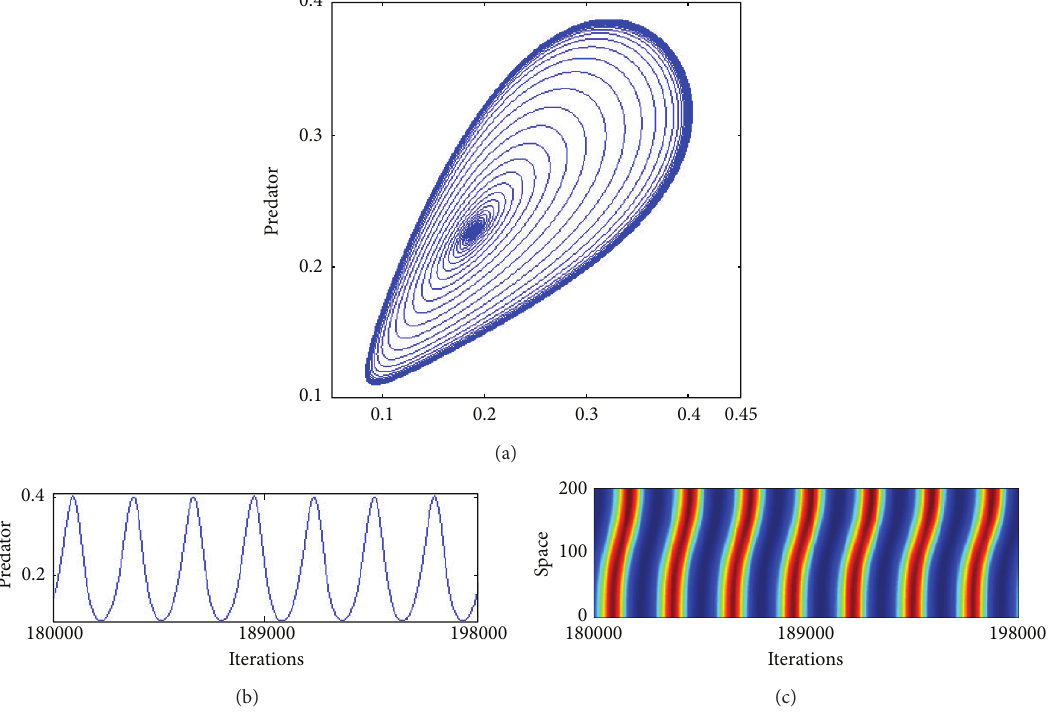
Figure 9: Dynamical behavior of system (3) when 𝑑 2 = 2 and 𝛿 = 0.34 : (a) phase portrait of system (3) for a fixed point (0.1892, 0.2270) , (b) time series of predator, and (c) space-time plots.